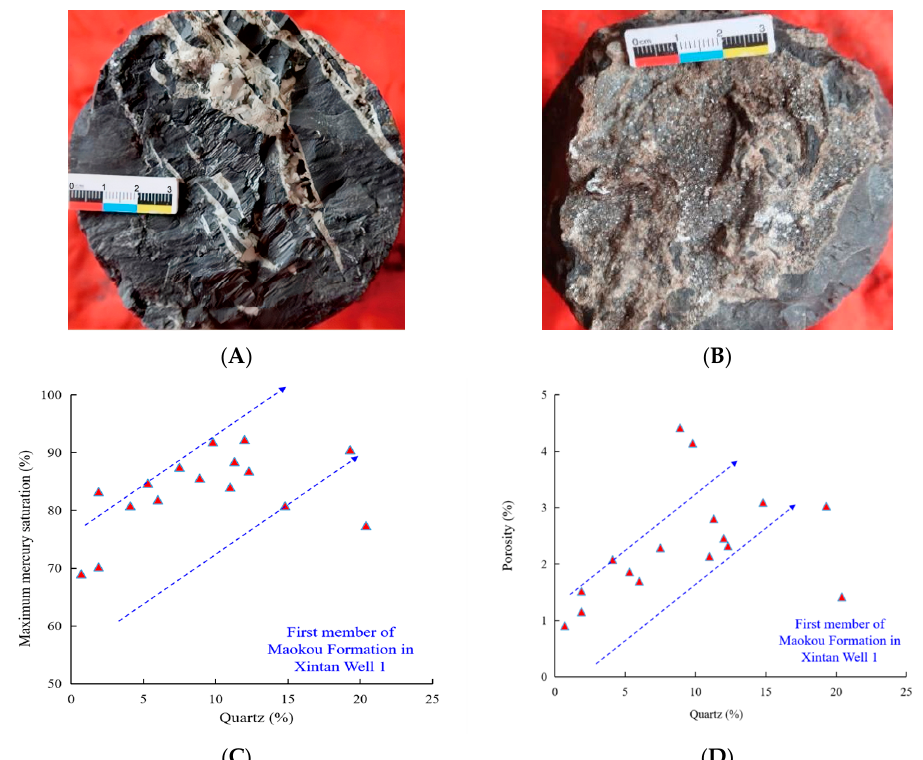
Figure 7. Brittle minerals in the first member of Maokou Formation in Eastern Sichuan improved the reservoir. ( A ): In the lower member a of the first member of Maokou Formation (4375.05 m), micrite and fractures developed and were filled with calcite. ( B ): In the lower member a of the first member of Maokou Formation (4383.55 m), fractures were filled with micrite and calcite. ( C ): Quartz and maximum mercury saturation diagram of the First member of Maokou Formation in Xintan Well 1. ( D ): Quartz and porosity diagram of the First member of Maokou Formation in Xintan Well 1.